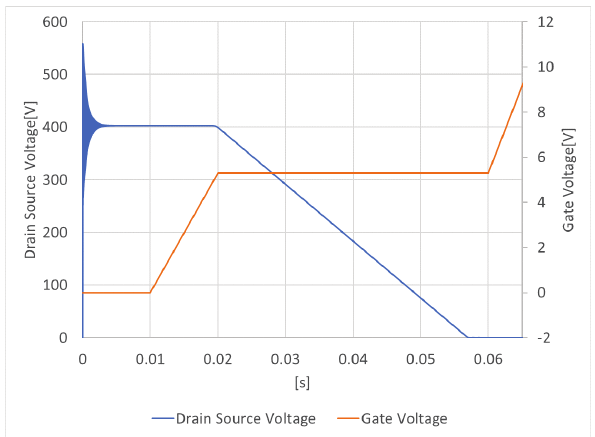
Fig. 8. MOSFET gate charge transfer curve.